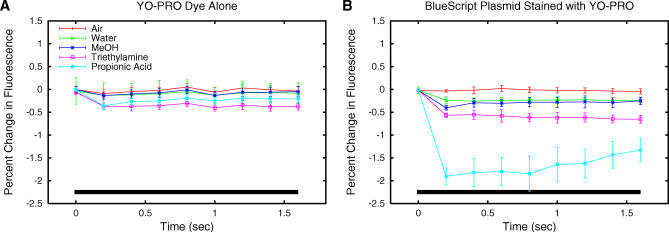
Changes in Fluorescence from Double-Stranded pBlueScriptSK DNA and YO-PRO Dye Sensors during Short Odor SniffsThe odor pulse began at 0 s and lasted for 1.6 s, indicated by horizontal black bar.(A) Responses of a sensor made from YO-PRO alone, then rinsed in 70% ethanol for 5 min.(B) Responses of a sensor made from YO-PRO and 5 ng total pBlueScriptSK DNA. Odor dilutions, expressed as fractions of saturated vapor, were: water, 10−1; methanol (MeOH), 10−1 (∼16,700 ppm); triethylamine, 10−2 (∼750 ppm); and propionic acid, 10−1 (∼390 ppm). Each trace represents the mean of 10 presentations; error bars indicate ± 1 SD.